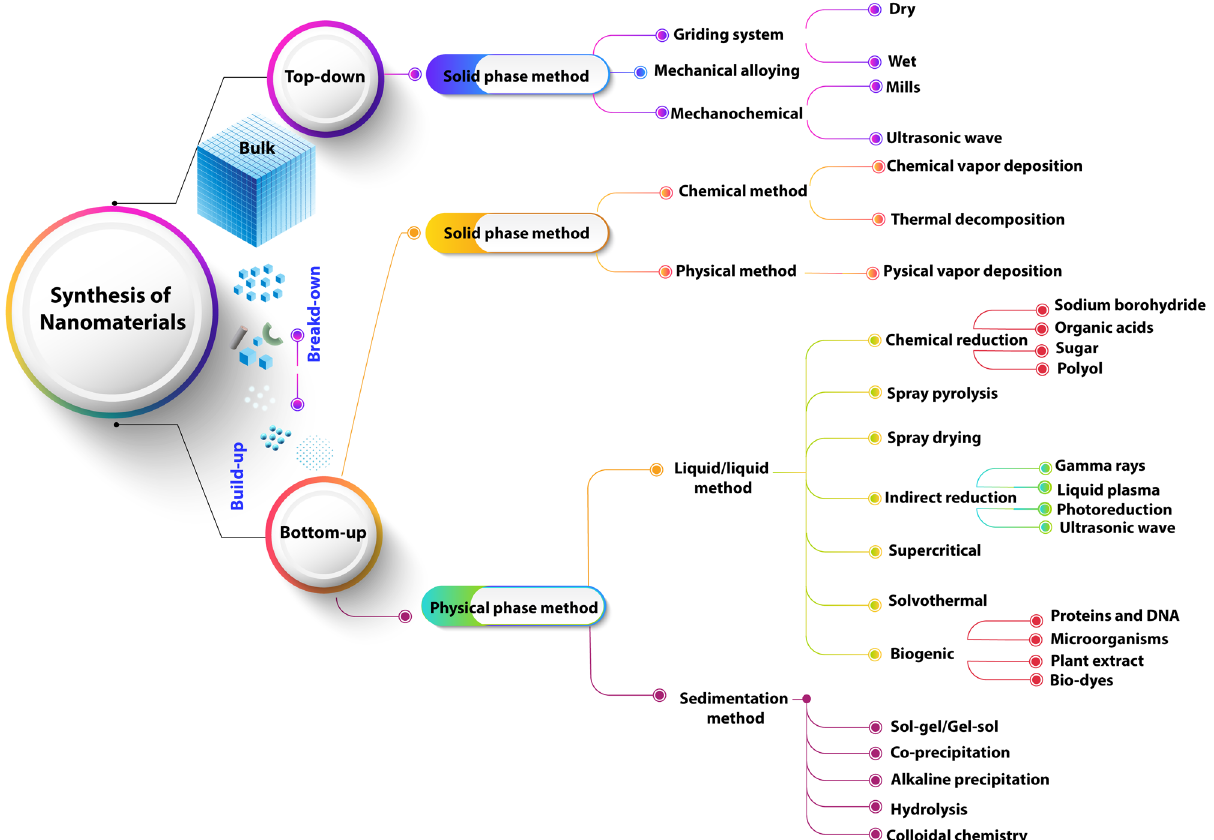
Figure 1: Synthesis routes for